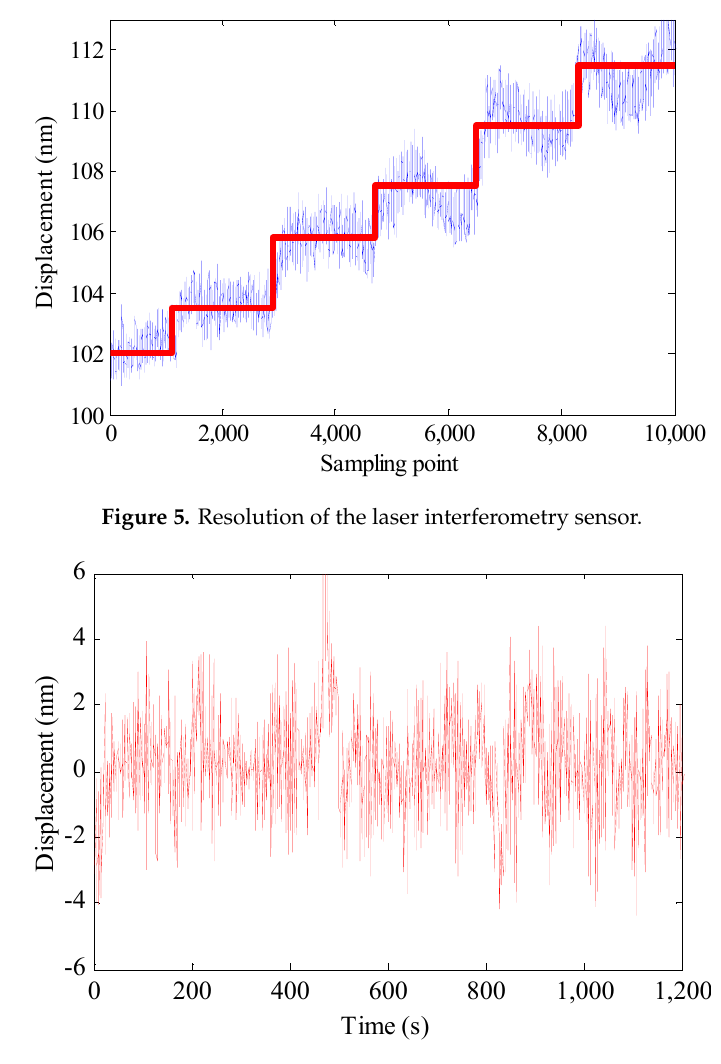
Figure 6. Stability of the laser interferometry sensor.